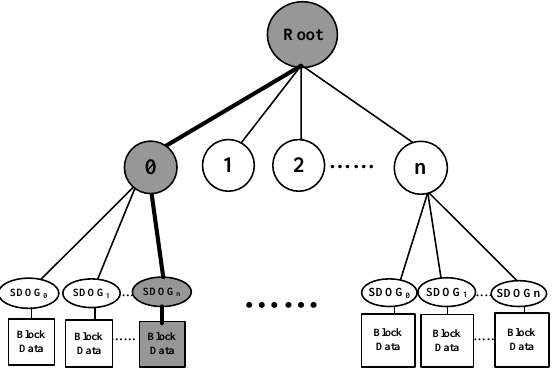
Figure 4. Structure of SDOG-ESSG Index